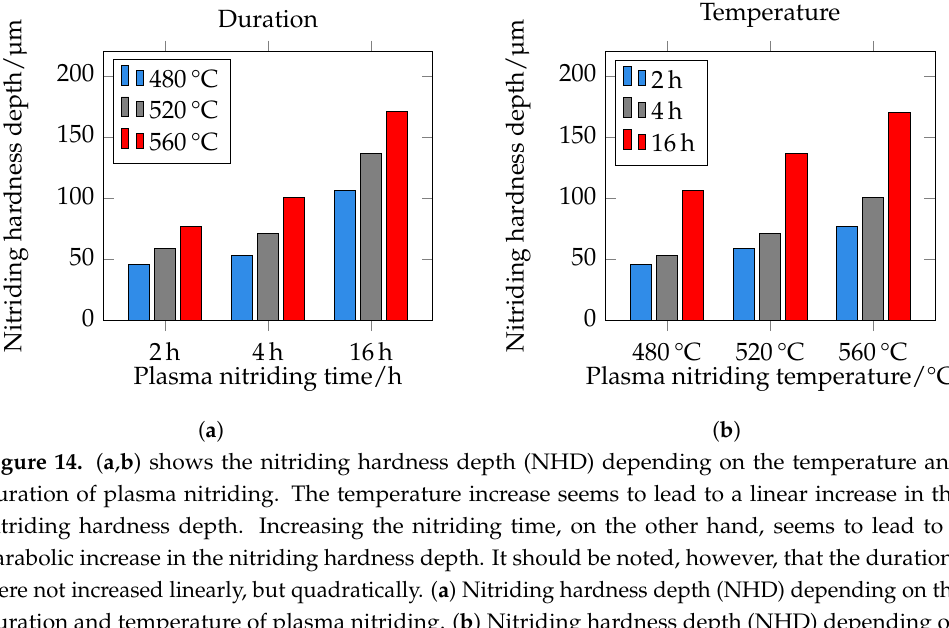
Figure 14. ( a , b ) shows the nitriding hardness depth (NHD) depending on the temperature and duration of plasma nitriding. The temperature increase seems to lead to a linear increase in the nitriding hardness depth. Increasing the nitriding time, on the other hand, seems to lead to a parabolic increase in the nitriding hardness depth. It should be noted, however, that the durations were not increased linearly, but quadratically. ( a ) Nitriding hardness depth (NHD) depending on the duration and temperature of plasma nitriding. ( b ) Nitriding hardness depth (NHD) depending on the temperature and duration of plasma